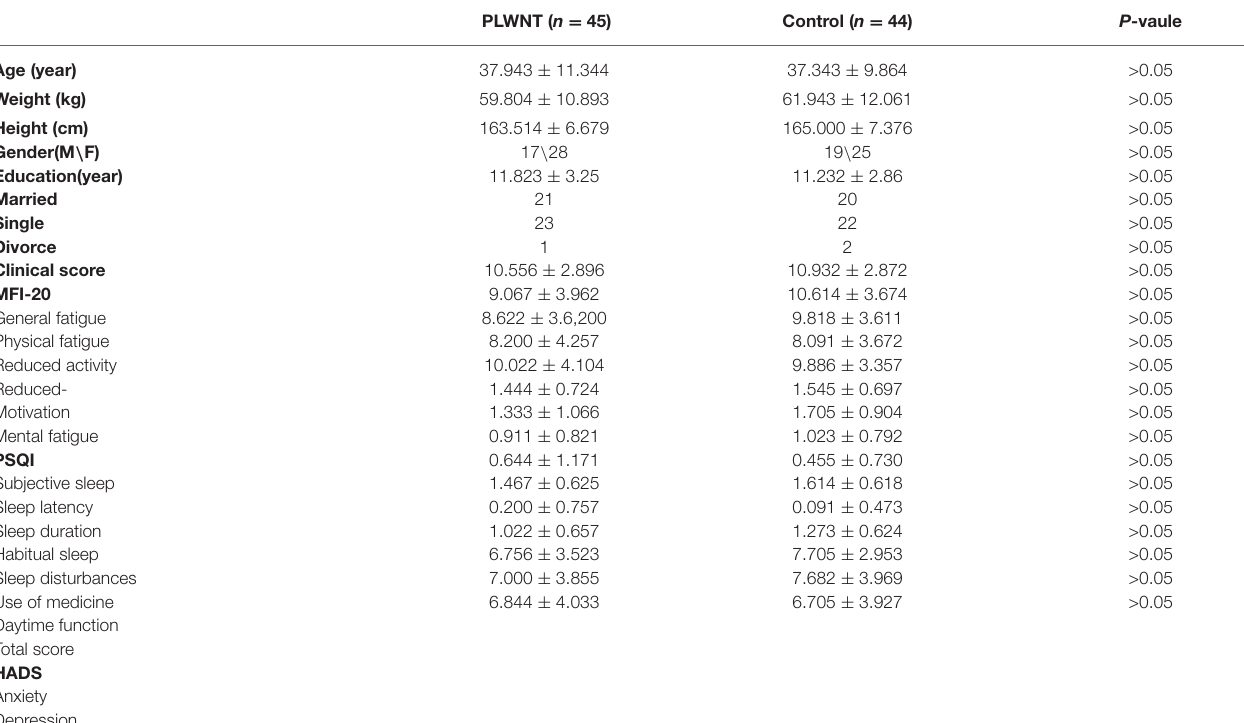
TABLE 1 | Demographic and clinical characteristics of the